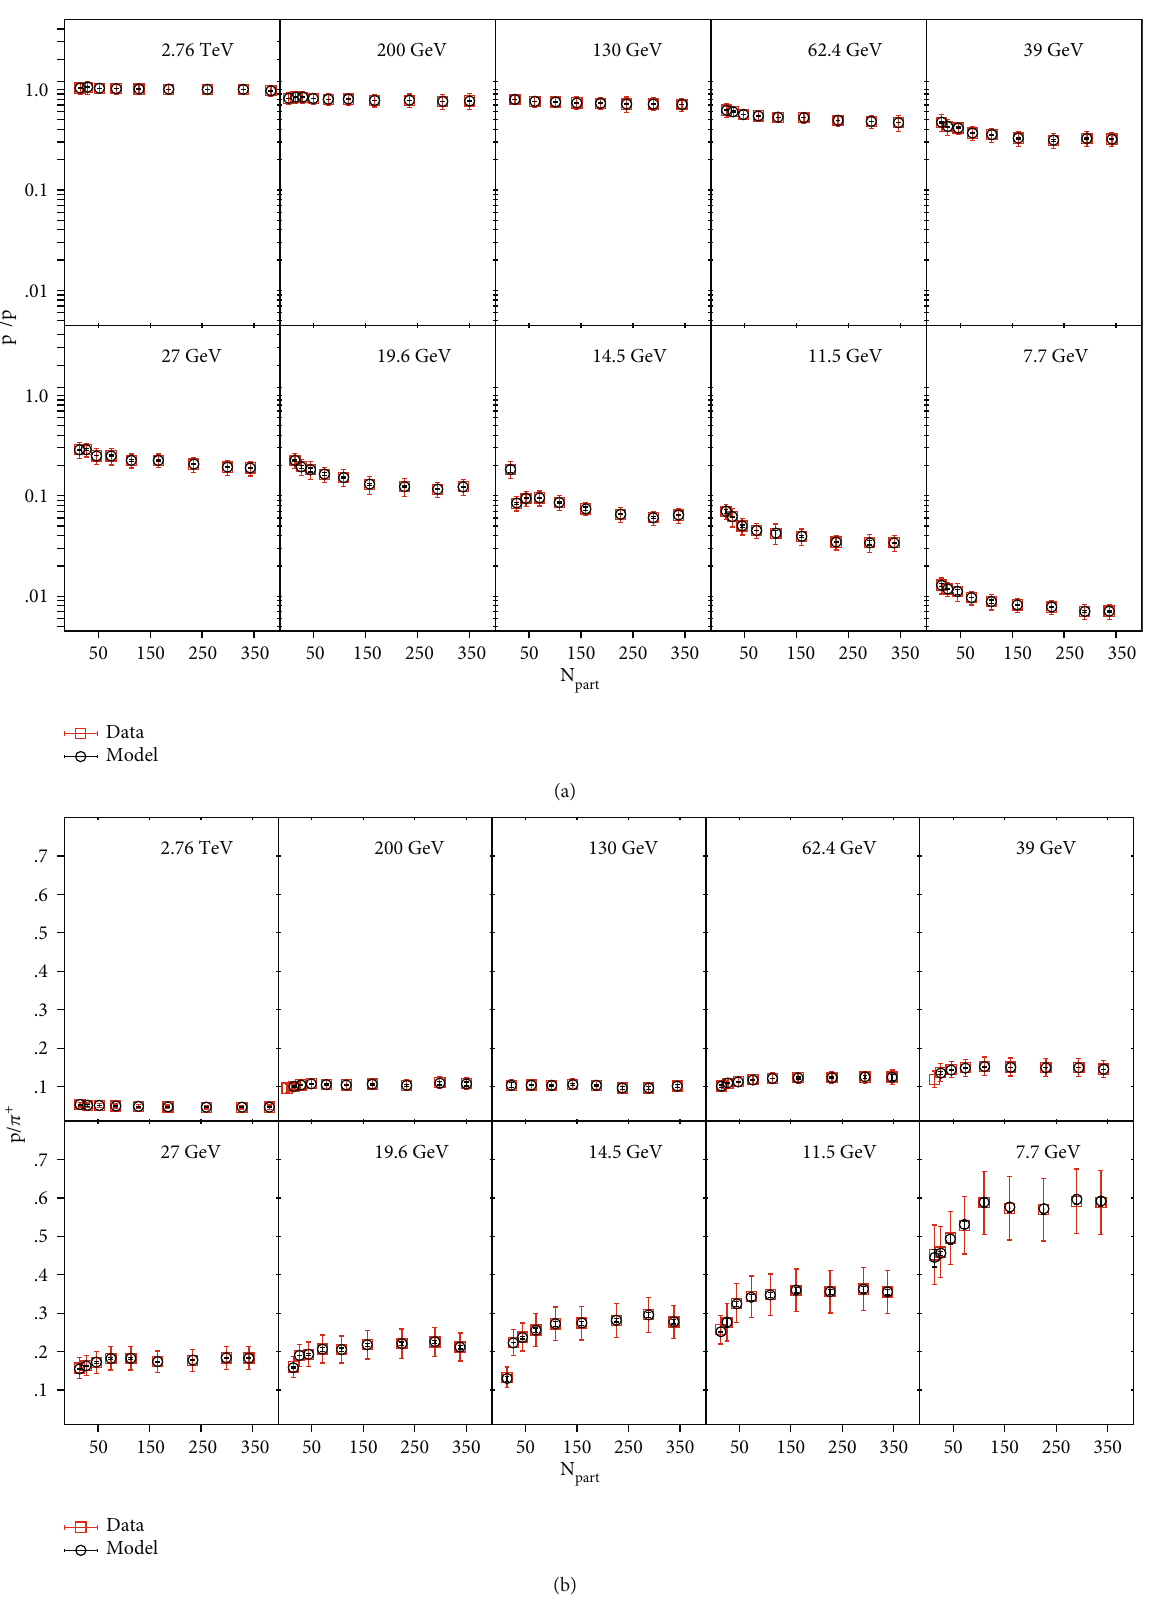
Figure 6: (Color online) N Ref. [6, 66, 68, 69]. Thermal estimations (black) are estimated from freeze-out